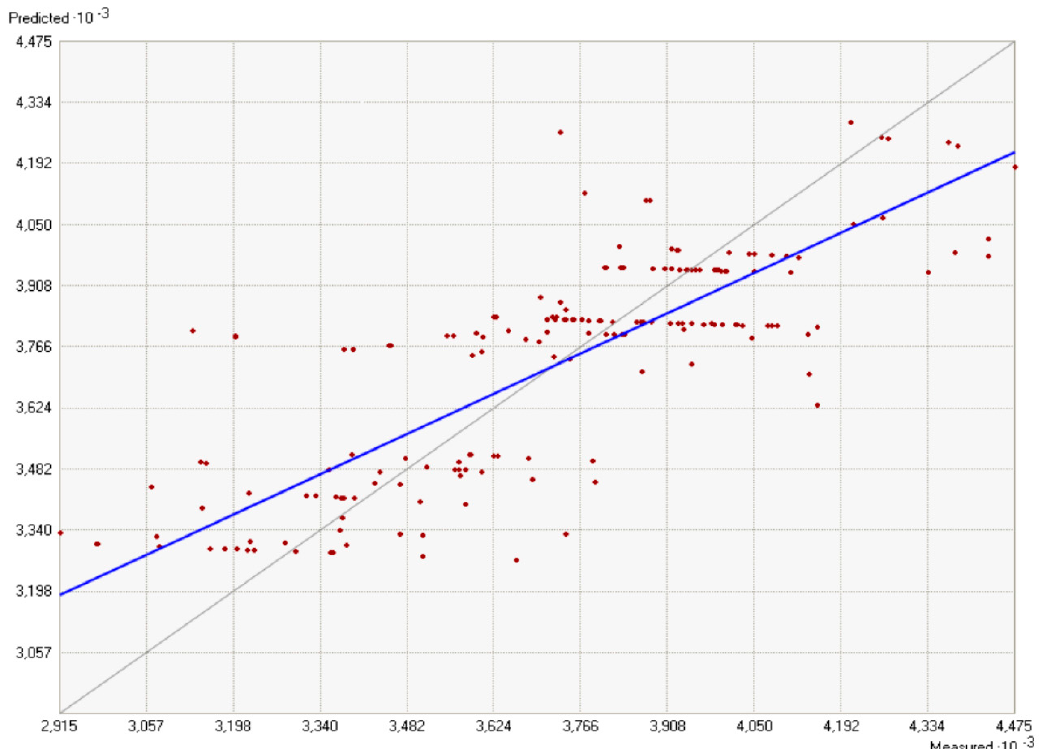
Figure 5. Chart of predictions of average property values for high-standard flats on the primary market (cluster